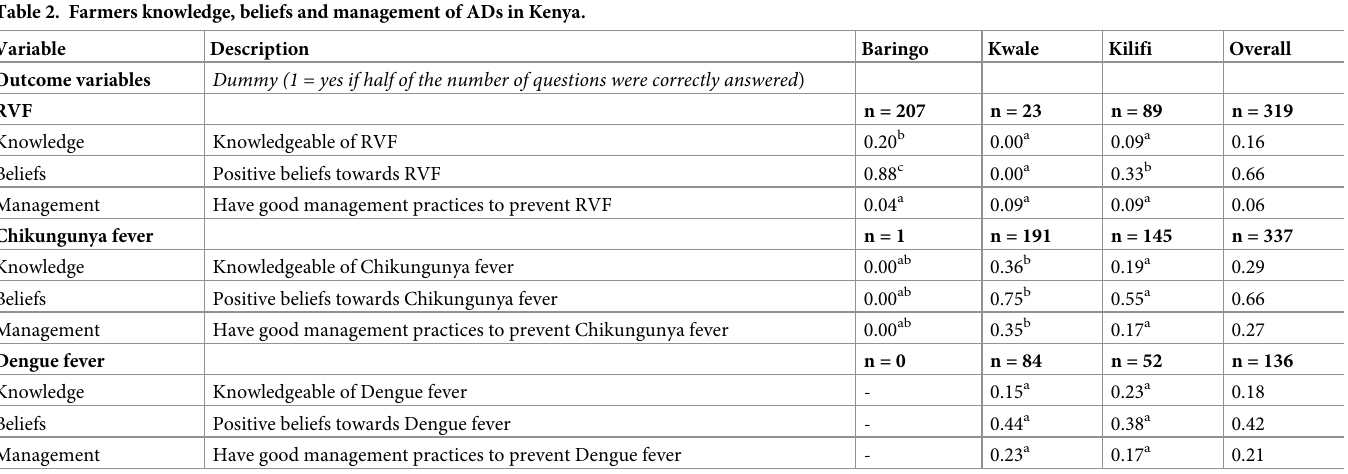
Table 2. Farmers knowledge, beliefs and management of ADs in